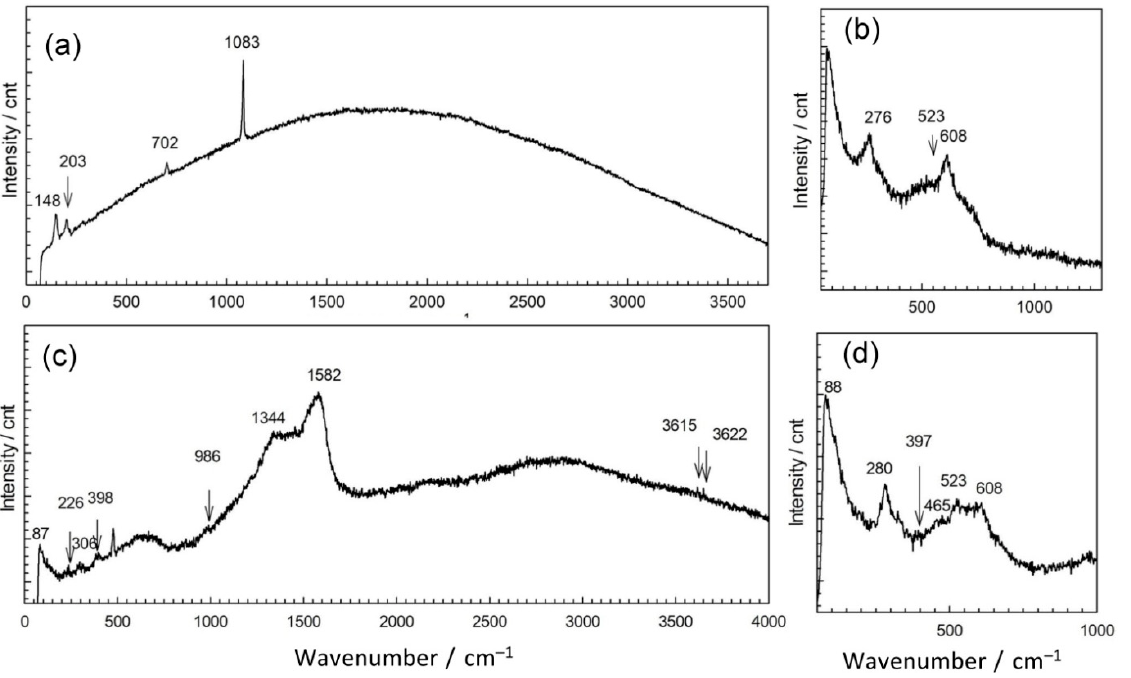
Figure 4. Raman spectra collected on patina samples from NI: point 1 ( a ), point 2 ( b ), point 3 ( c ), and point 4 ( d ). ATR-FTIR spectrum of this patina sample is given in Figure 5. Broad bend in 3200– 3500 cm − 1 region can be attributed to OH stretching. Two bands were observed at 1456 and 1415 cm − 1 that were probably related to the presence of carbonates